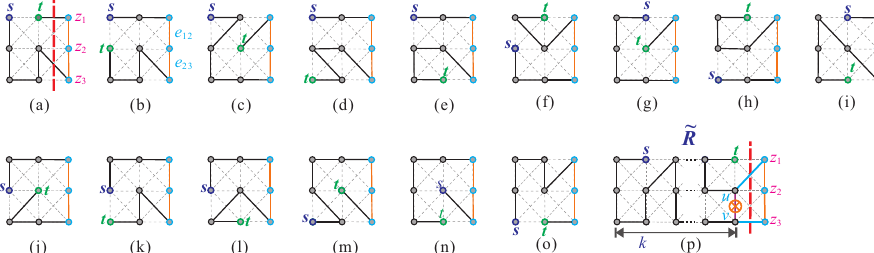
Figure 7. ( a – o ) The possible Hamiltonian ( s , t ) -paths of R ( 3,3 ) when s , t (cid:54)∈ { z 1 , z 2 , z 3 } , and ( p ) the construction of Hamiltonian ( s , t ) -path of R ( k + 1,3 ) for k (cid:62) 3 and s , t ∈ ˜ R , where the solid lines indicate the constructed Hamiltonian ( s , t ) -path and ⊗ represents the destruction of an edge while constructing a Hamiltonian ( s , t ) -path of R ( k + 1,3 ) .